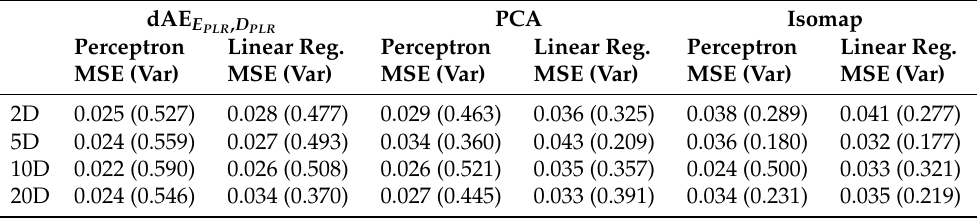
Table 3. Performance of the Easy model. MSE and variance values are rounded to the third digit after the decimal